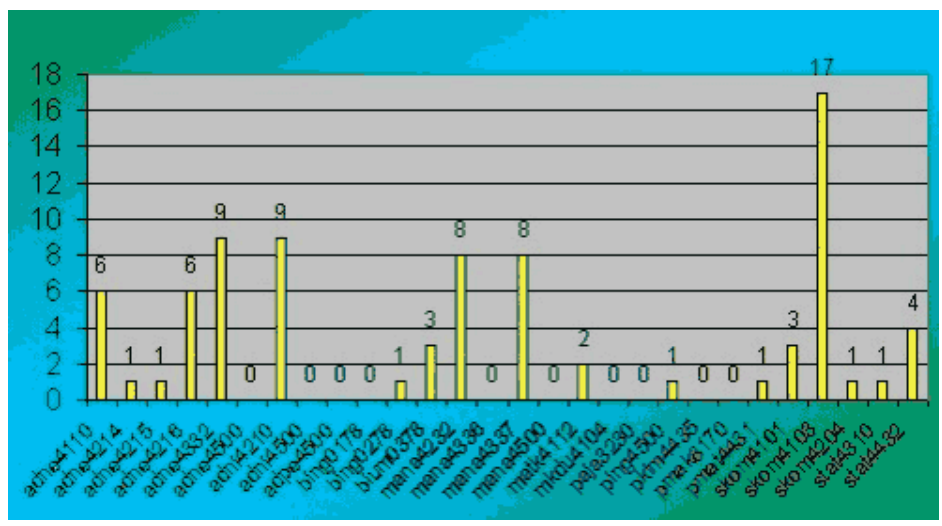
Figure 4. Student/ Tutor interaction rates per